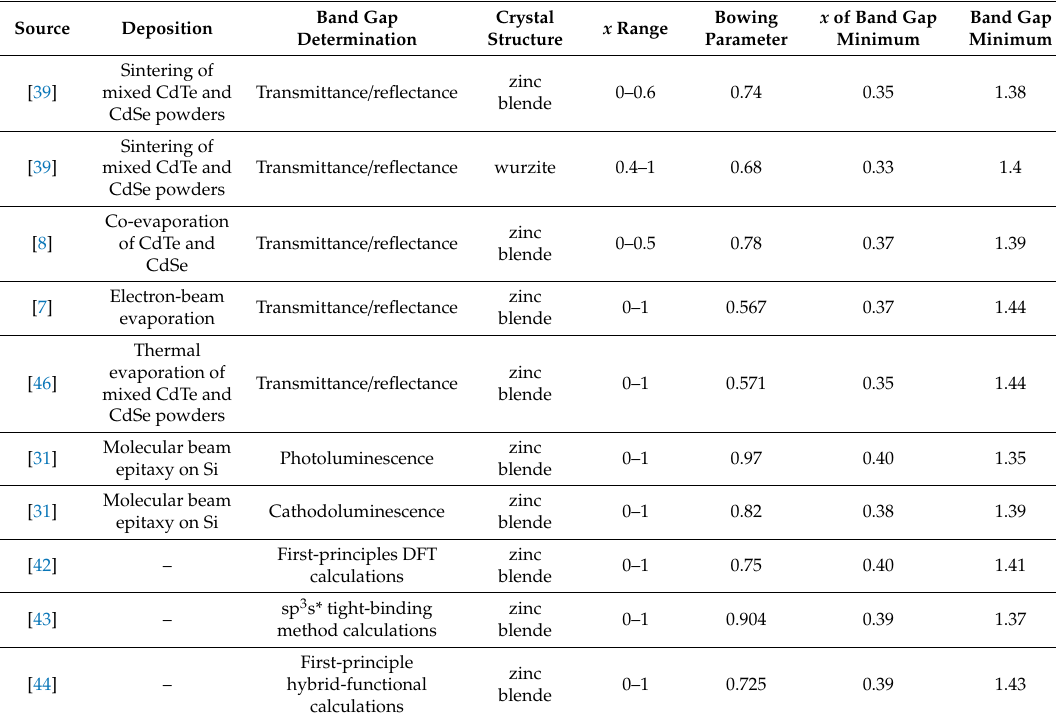
Table 1. Band gap bowing parameters of layers and powders synthesized with di ff erent